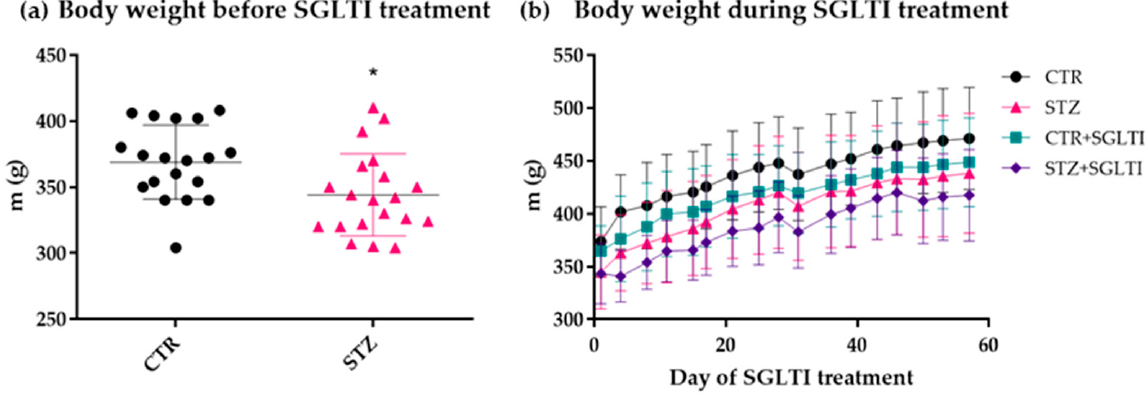
Figure 2. Body weight before initiation ( a ) and during ( b ) phloridzin treatment. Rats were weighed regularly (2 × per week) during the 2-month-long phloridzin treatment. Data presented as mean ± SD with individual animal data and analysed by the student’s t -test ( a ) and presented as mean ± SD and analysed by 2-way repeated measures ANOVA with Tukey’s multiple comparisons test between groups ( b ). bw—body weight; SGLTI—sodium–glucose co-transporter inhibitor; CTR—control group; STZ—streptozotocin-treated group; CTR+SGLTI—control group treated with phloridzin; STZ+SGLTI—streptozotocin-treated group treated with phloridzin. * p <